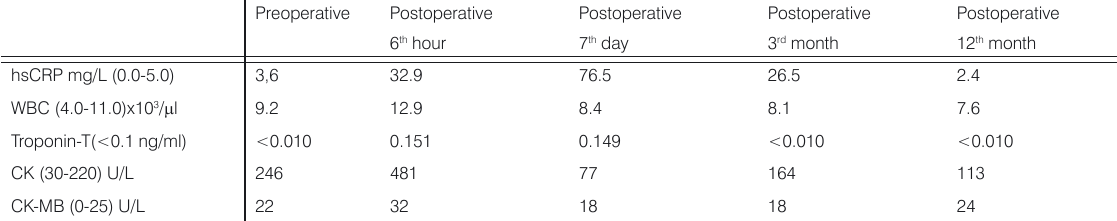
Table 5. Comparison of pre and postoperative biochemical data related to inflammation and myocardial